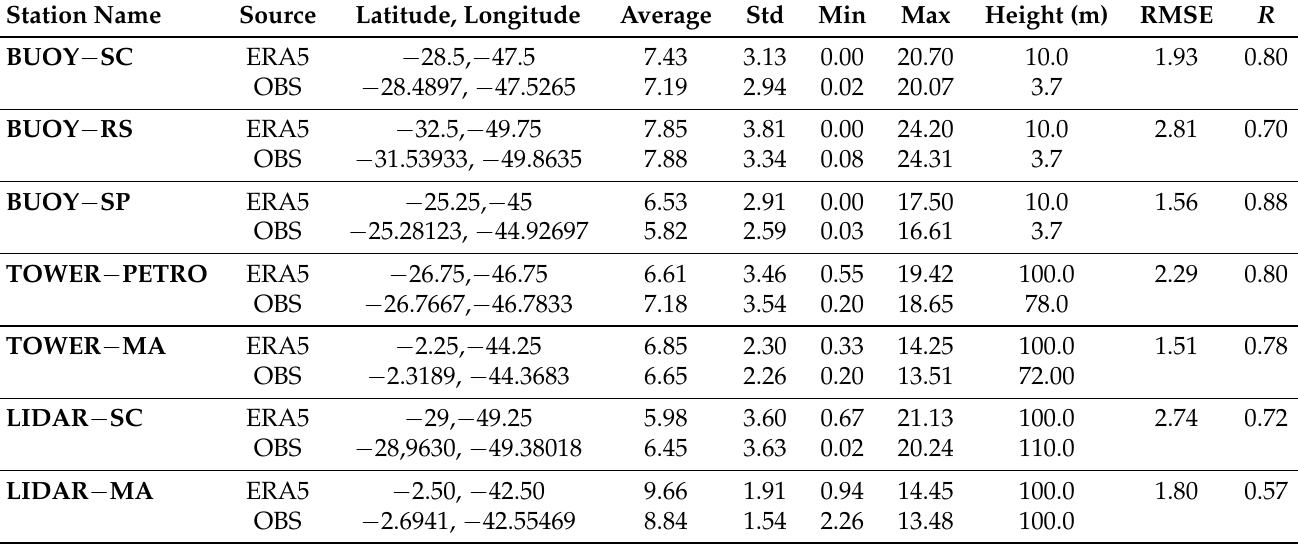
Table 2. Observational point (OBS) coordinates and statistics compared with ERA5 neighboring stations. Wind speed average, standard deviation ( std ), minimum and maximum values, root mean squared error ( RMSE ), and Pearson’s correlation coefficient ( R ) are listed. The column “height” lists the original data height. Whenever necessary, observations are adjusted to comparison heights of 10 m for buoys and 100 m for towers or LIDAR. The anemometer height TOWER-MA is 72 m above the ground level over a cliff that is 40 m above the sea level, making its wind measurement 112 m above the mean sea level. The distance from observational points to ERA5 grid positions is less than 22 km in all